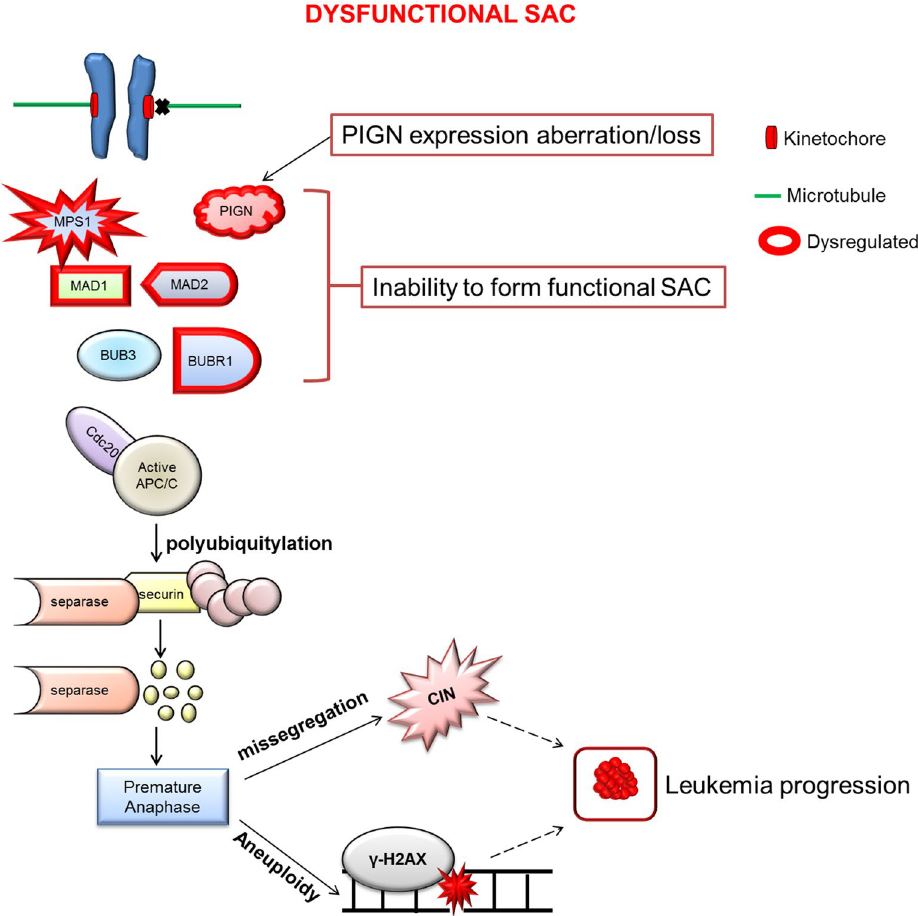
Figure 6. Model summarizing the relationship between PIGN expression aberration, SAC regulation, and leukemia progression. PIGN depletion results in SAC dysregulation and ultimately results in segregation errors and aneuploidy which contribute to leukemia progression. PIGN plays a vital role in the regulation of mitotic integrity to maintain chromosomal